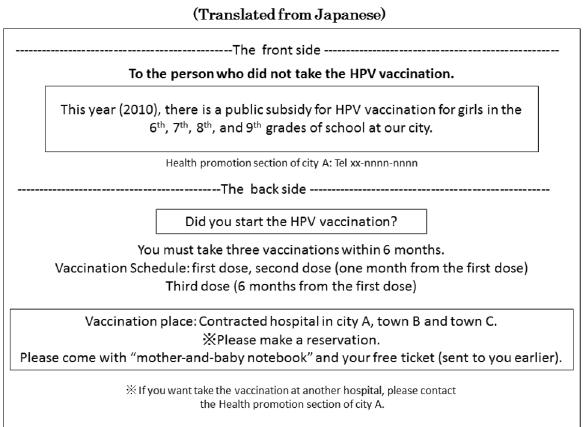
Figure 3. Recall. Recall notices were mailed once to people who after several months did not respond to the direct mail campaign by scheduling a vaccination. The sample provided here is an anonymized translation from Japanese of a recall notice by one city that collaborated with two towns.